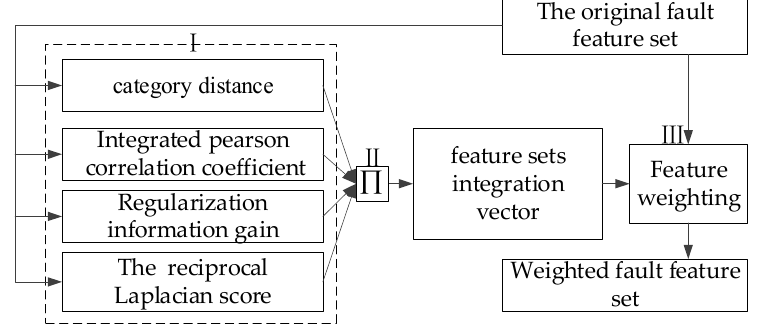
Figure 1. Flowchart of proposed feature ‐ weighting scheme.